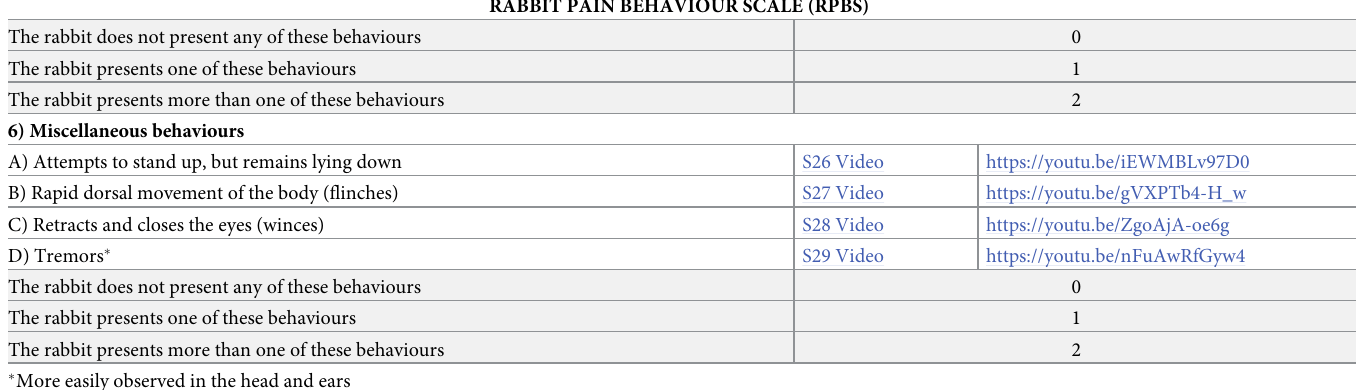
square, comparative fit index, Tucker Lewis index, loglikelihood, root mean square error of